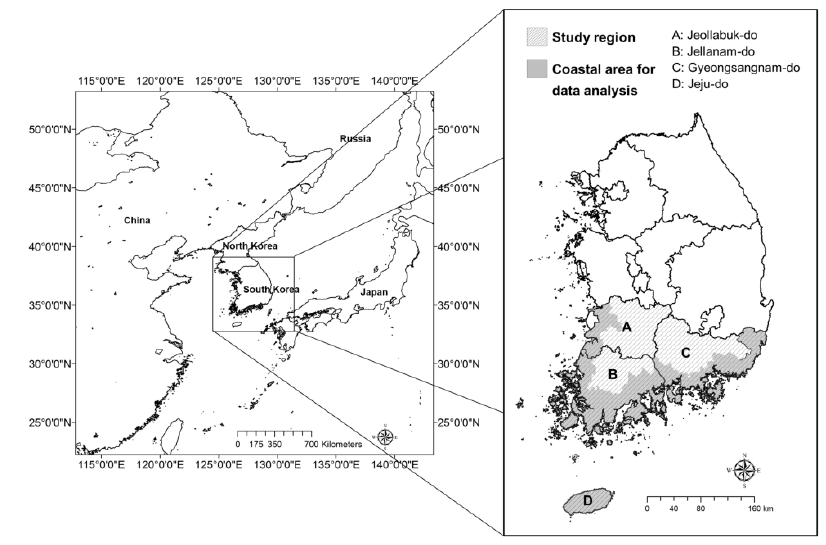
Figure 2. Study area with four regions